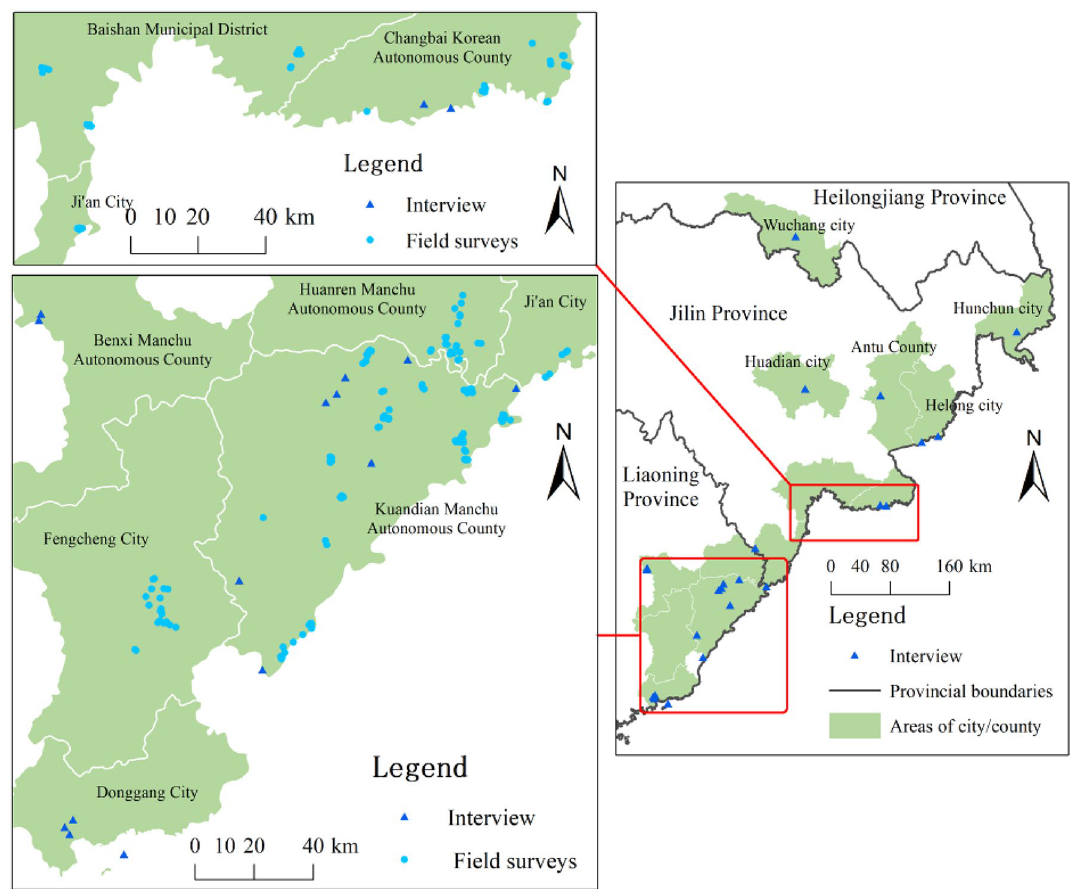
Figure 2. The distribution status of water deer in Northeast China based on our field surveys and interview. The circular points come from line transects survey and infrared camera monitoring, the triangular points come from interview. This map was generated with ArcGIS 10.7 (Environmental Systems Research Institute, Inc. in Redlands, California, USA. URL: https:// www. esri. com/ en- us/ arcgis/ produ cts/ arcgis- deskt op/ overv iew).